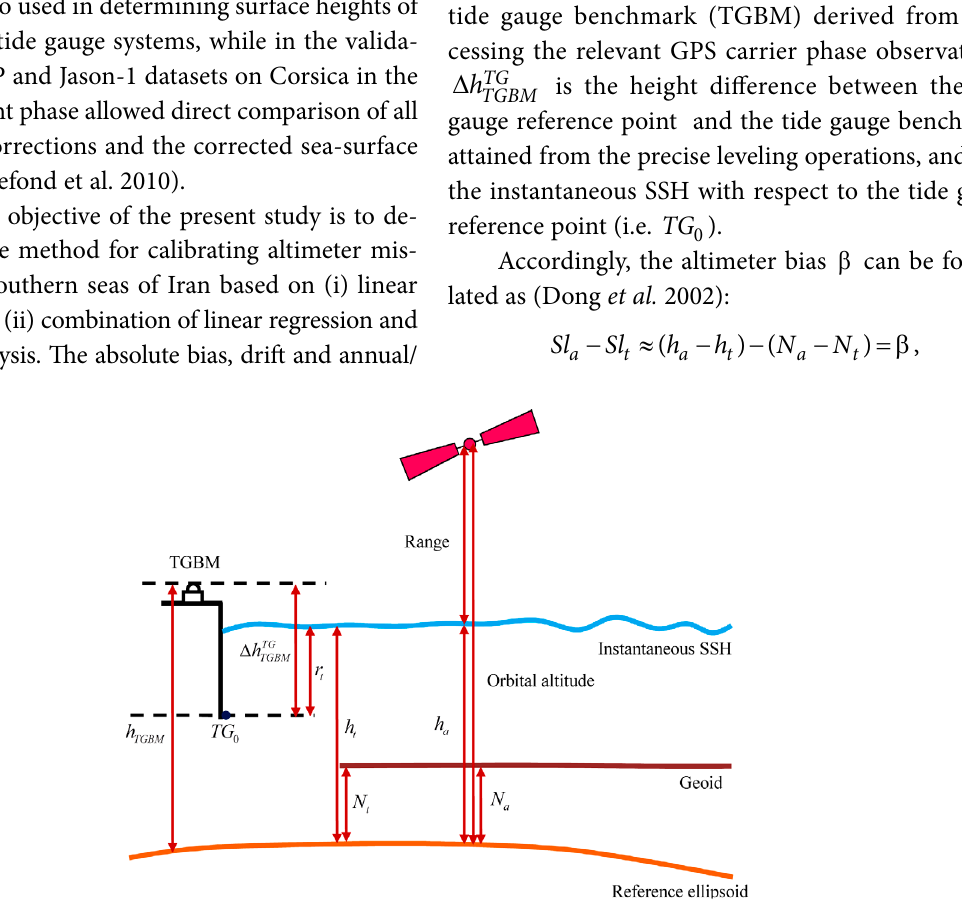
Fig. 1. Schematic view of relations between instantaneous sea surface heights measured TG ) with respect by coastal tide gauge from the tide gauge reference point ( 0 to the reference ellipsoid and